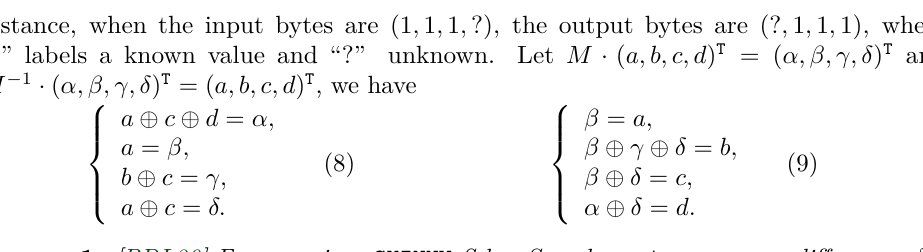
256 Automated Search Oriented to Key Recovery on Ciphers with Linear Key